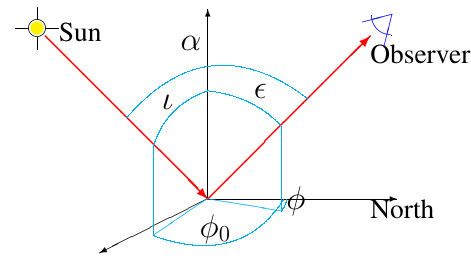
Figure 1. Definition of the angles used in surface reflectance work: (cid:15) and ι are the zenith angles of the emergent (observer) and incident (solar) radiation respectively (shorthand µ = cos (cid:15) and µ 0 = cos ι are also used). φ and φ 0 are the corresponding azimuth angles. The phase angle α is the angle between the observer and the Sun. The principal plane is fixed by the solar direction and the surface nor- mal, while the cross plane is a vertical plane perpendicular to the principal